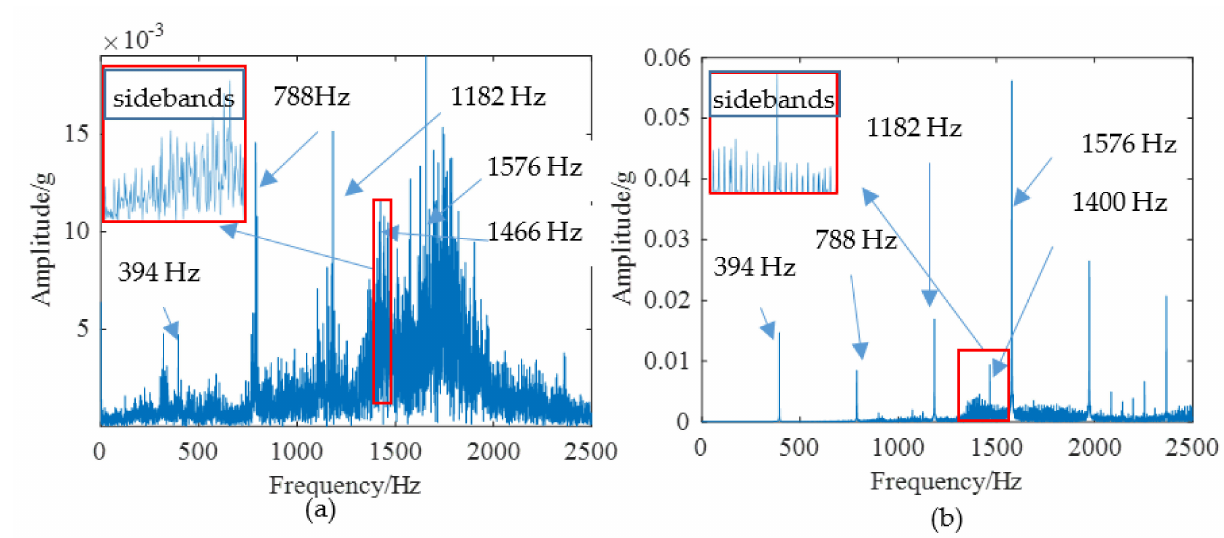
Figure 14. The spectrum of spalling fault signal: ( a ) Experimental, ( b )